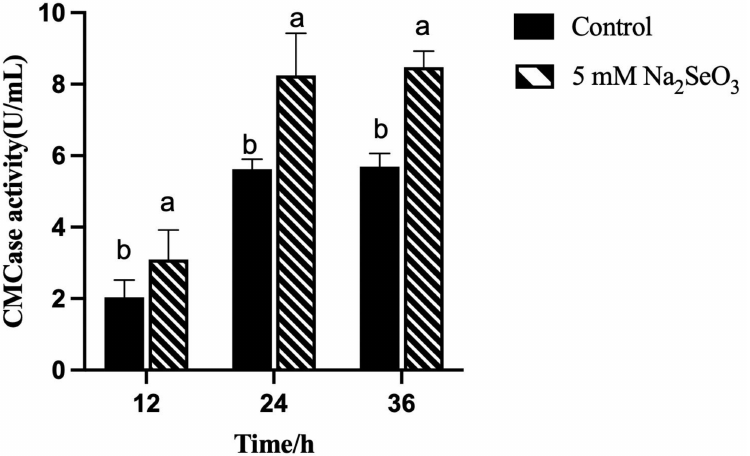
Figure 12. CMCase activity was produced by culture medium containing different concentrations of selenite at 37 ◦ C after 24, 48, and 72 h by B. paralicheniformis Y4. The different alphabetic superscripts in the same column are significantly different ( p < 0.05) based on Tukey’s multiple comparison